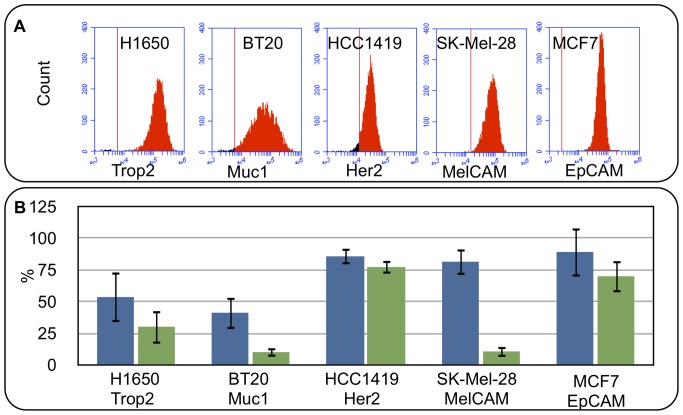
CTC Flow cell operation and performance.(A) Flow cytometry histograms of H1650, BT20, H1419, SK-Mel-28 and MCF7 cells labeled with 1 ug/mL of anti Trop2, Muc1, Her2, MelCAM and EpCAM antibodies respectively. Control antibody threshold is indicated by the red line (B) Recovery and purity of target cells using magnetophoretic capture from NHD blood: 90 cells/mL were spiked into NHD blood and purified on the LiquidBiopsy platform. Recovered cells were enumerated in the flow cell. Graphs show average recovery and purity of target cells +/−1 SD from 4 experiments for H1650, BT20, H1419 and SK-Mel-28 capture and 100 experiments for MCF7 capture.